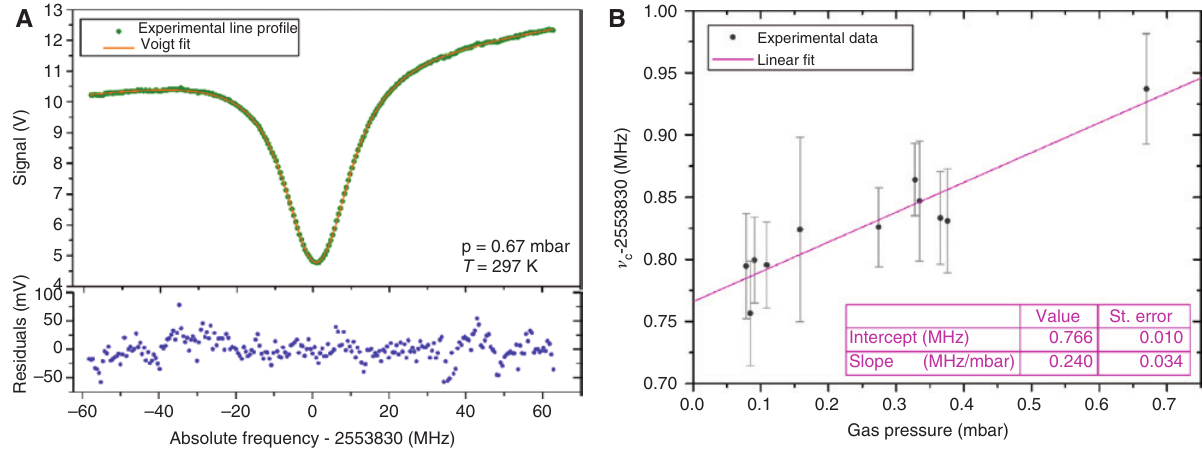
Figure 16: QCL-based high-precision spectroscopy on low pressure methanol vapours. (A) Experimental absorption profile (green dots) and Voigt function fit (red line) with residuals (blue dots, bottom panel), for the investigated line. Gas pressure and temperature during the acquisition are also reported. (B) Dependence of the centerline frequency on gas pressure (black dots), with the corresponding linear fit (purple line). The intercept and the slope values of the fit give the absolute frequency ( ν the pressure shift of the considered line. Reprinted with permission from [41], copyright